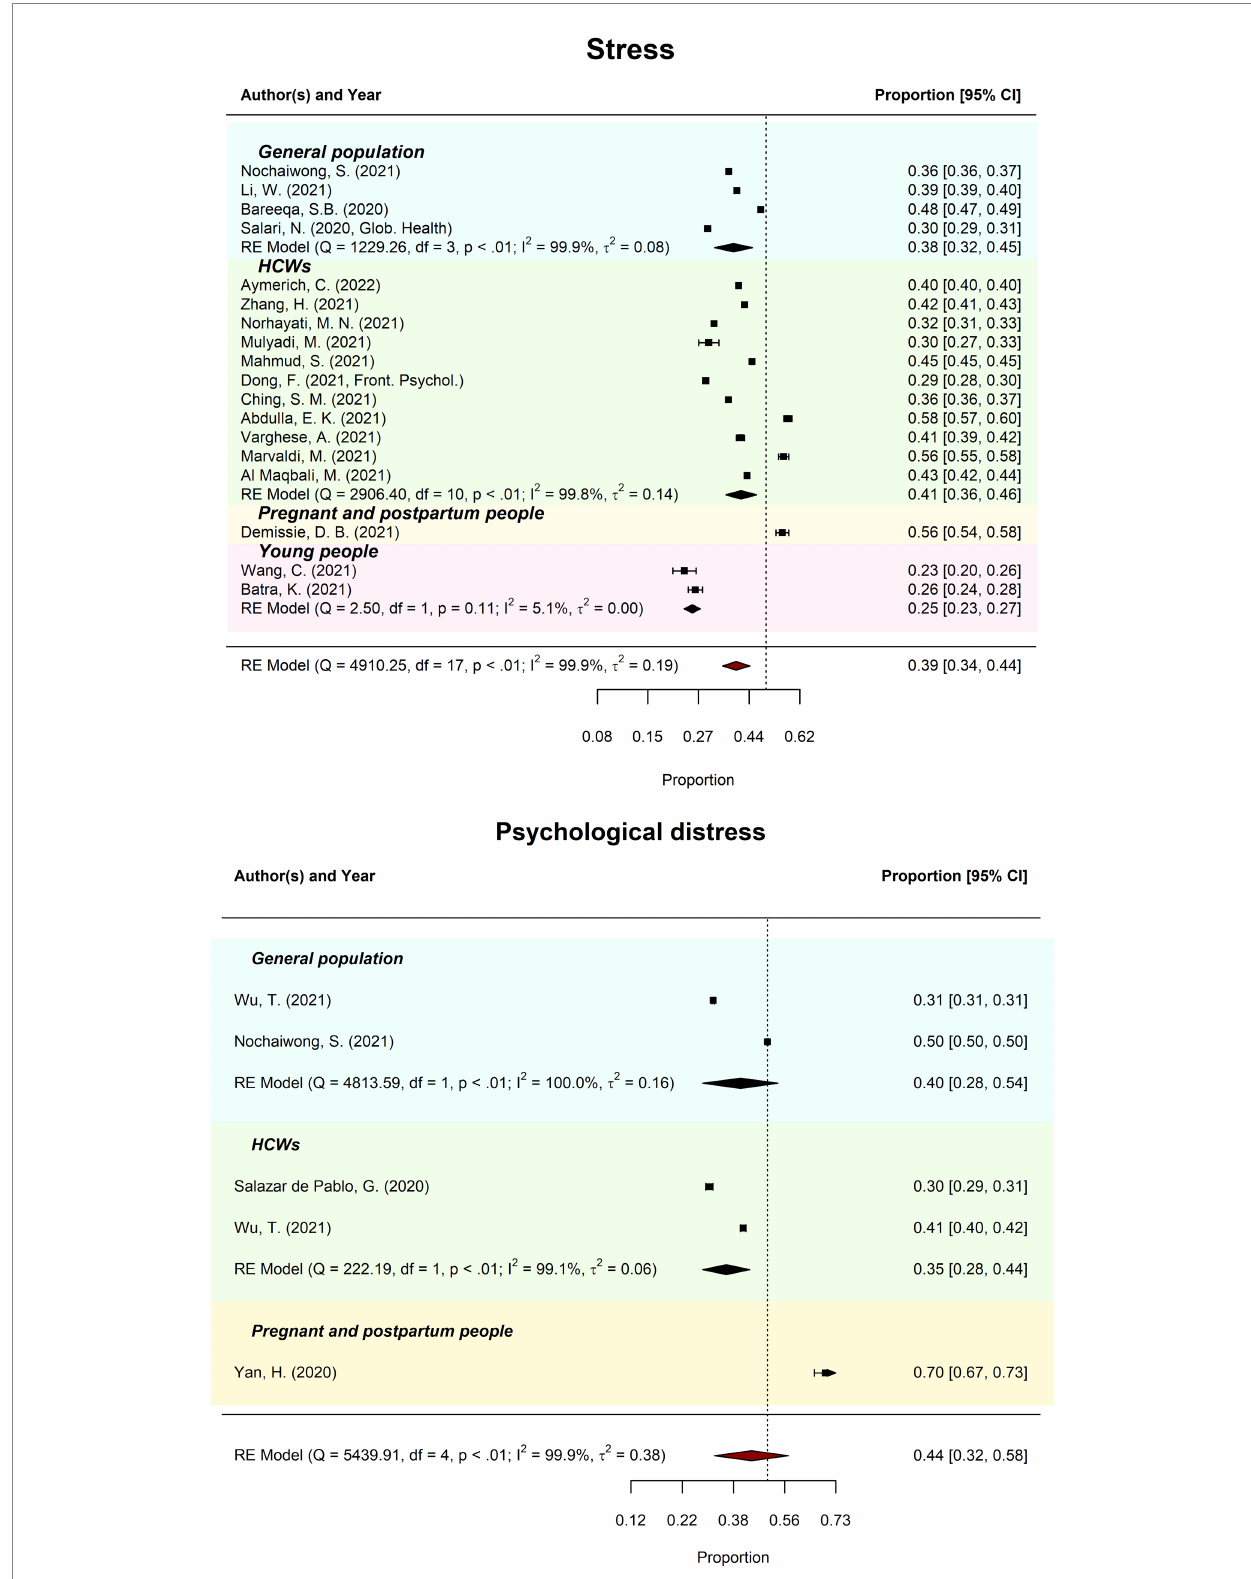
FIGURE 4 Meta-reviews of pooled prevalence of stress and psychological distress. The forest plots of the pooled prevalence (and 95% CIs) for stress across the general population, healthcare workers (HCW), pregnant and postpartum people, and young people (above) and psychological distress amongst the general population, HCW, and pregnant and postpartum people